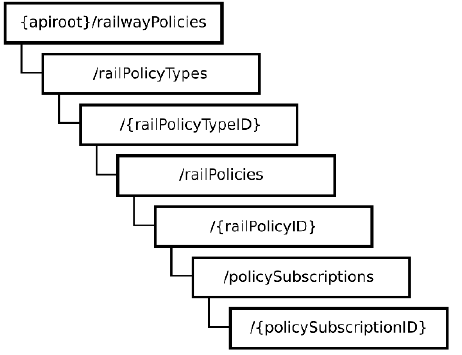
Figure 6. Structure of URI of the railway policy resources.